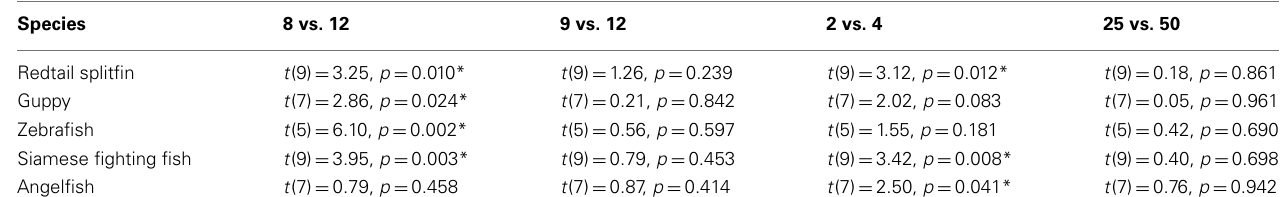
Table 1 | Performance of the five species in the numerical contrasts presented during test phase.